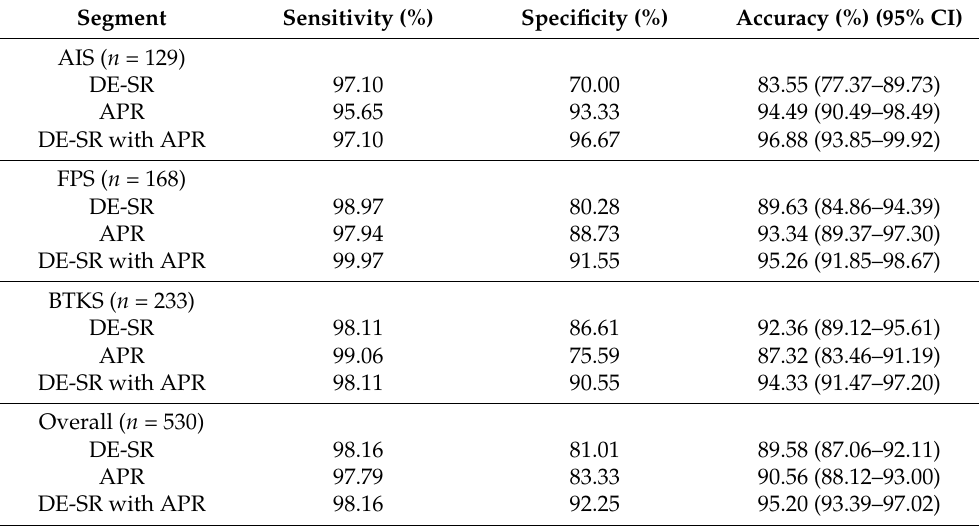
Table 3. Sensitivity, specificity, and accuracy according to arterial segment.